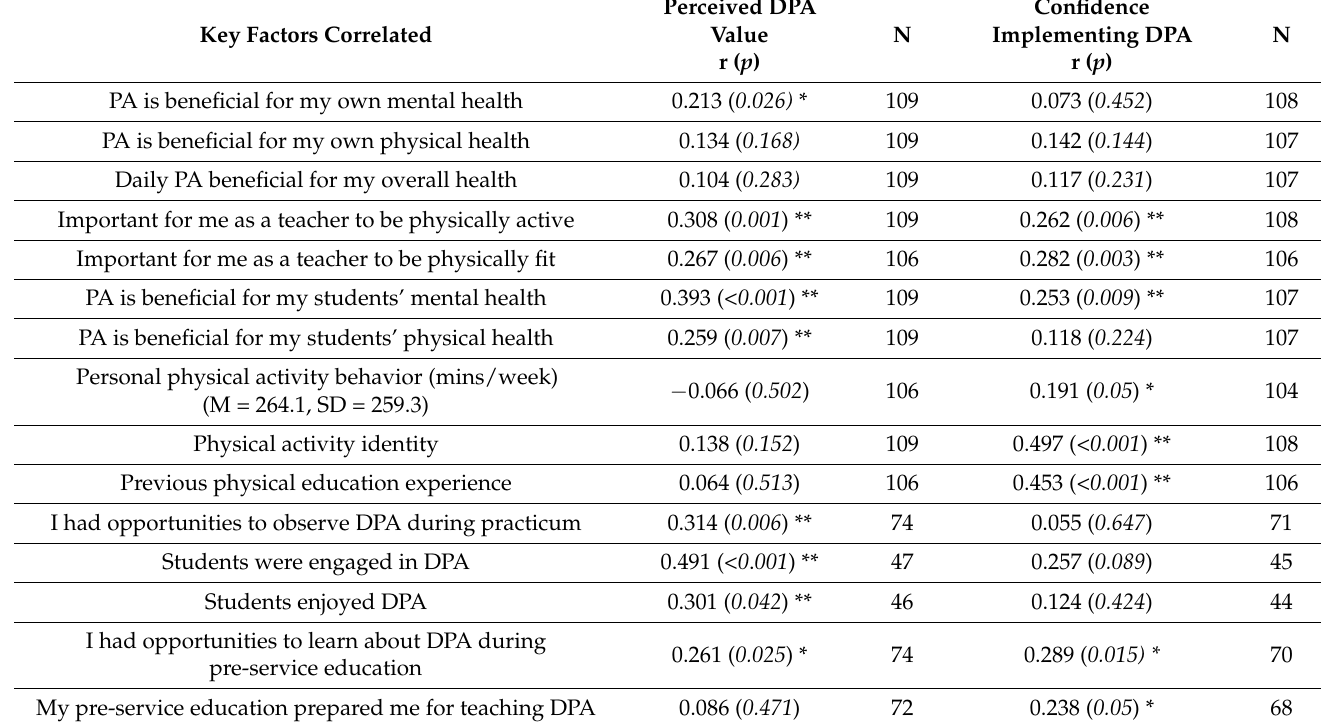
Table 4. Key factors related to pre-service teachers’ perceptions of DPA value and confidence implementing